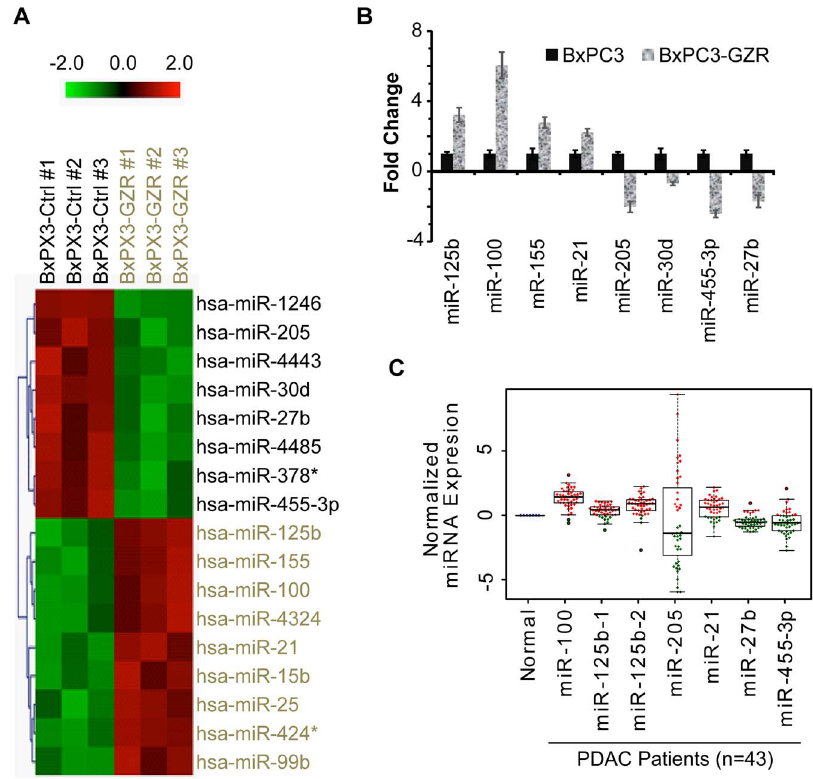
Figure 2. miRNA signature of BxPC3-GZR cells. A. Heat map data analysis of the miRNA microarray assays comparing BxPC3 parental cells and drug resistant BxPC3-GZR cells. Only miRNAs were chosen which had significantly over or under expressed as compared to parental cells (high fold changes based on log2 values and very low p-values) were taken for further validation. The statistical values are represented in the Table 1 . B. Validation of miRNA microarray data was done for eight differentially expressed miRNAs using TaqMan qPCR assay. In each cell line, the expression level of indicated miRNA was compared between parental BxPC3 cells and BxPC3-GZR cells. RNU43 or U6 was used as an internal miRNA control. C. TCGA data analysis showing that 6 of the 7 miRNAs validated for being deregulated in BxPC3-GZR cells also showed differential expression in tumor specimens from patients with advanced PDAC. Tumor specimens from 43 patients with advanced PDAC were analyzed for miRNA expression compared to normal pancreas tissue.